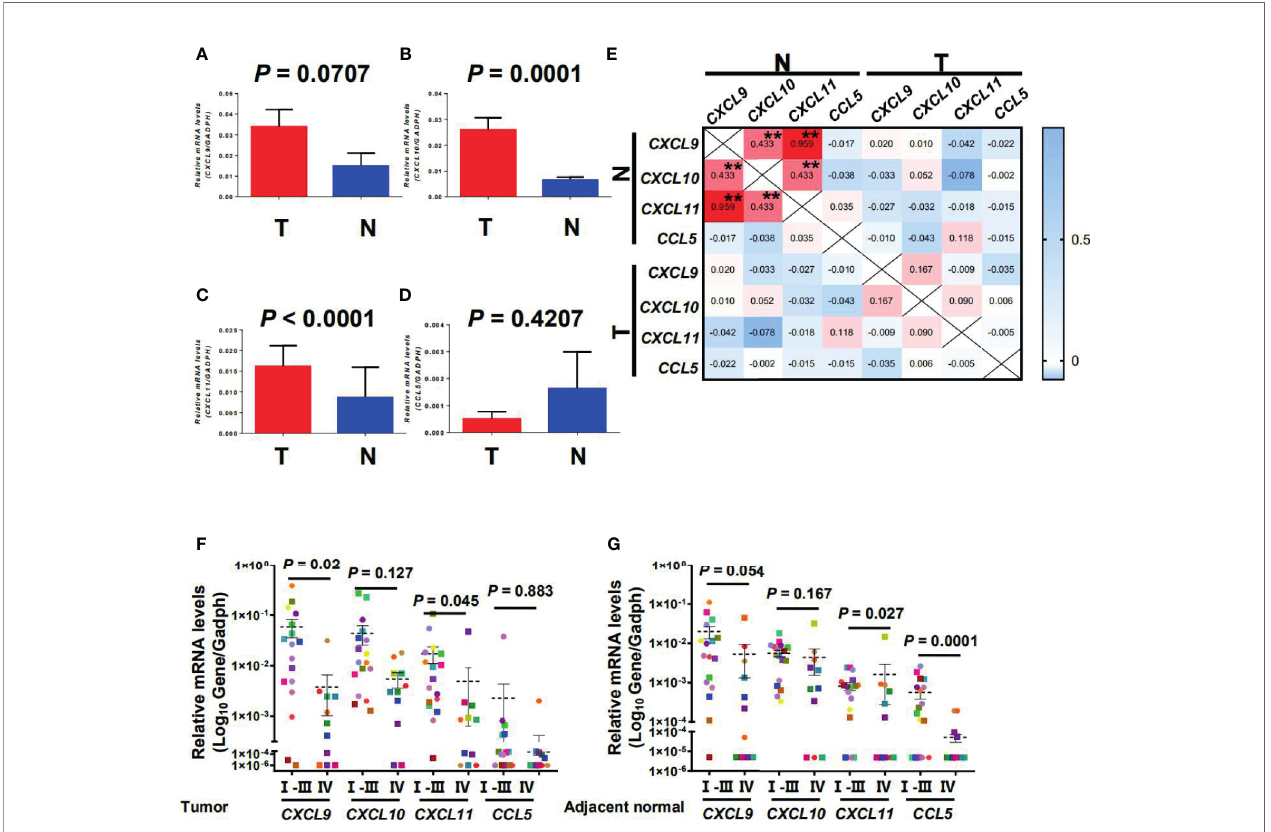
FIGURE 1 | CXCL9, CXCL10, CXCL11 , and CCL5 were selectively regulated in tumor and adjacent normal tissues and decreased with progressive stages in CRC patients. Quantitative real-time polymerase chain reaction (qPCR) results of gene expression are shown for CXCL9, CXCL10, CXCL11 , and CCL5 in tumor and adjacent normal tissues ( n = 136) (A – D) . T, Tumor; N, Adjacent normal. Results are expressed as means ± SEM. (E) Correlation between the relative expression level of CTTCs in tumor and adjacent normal tissues. Pearson correlation coef fi cients calculated from the relative expression of CTTCs are shown. ** p < 0.001. (F, G) Representative dot plots of at least three individuals from more than three independent experiments; the continuous and dashed horizontal bars in (F, G) represent median